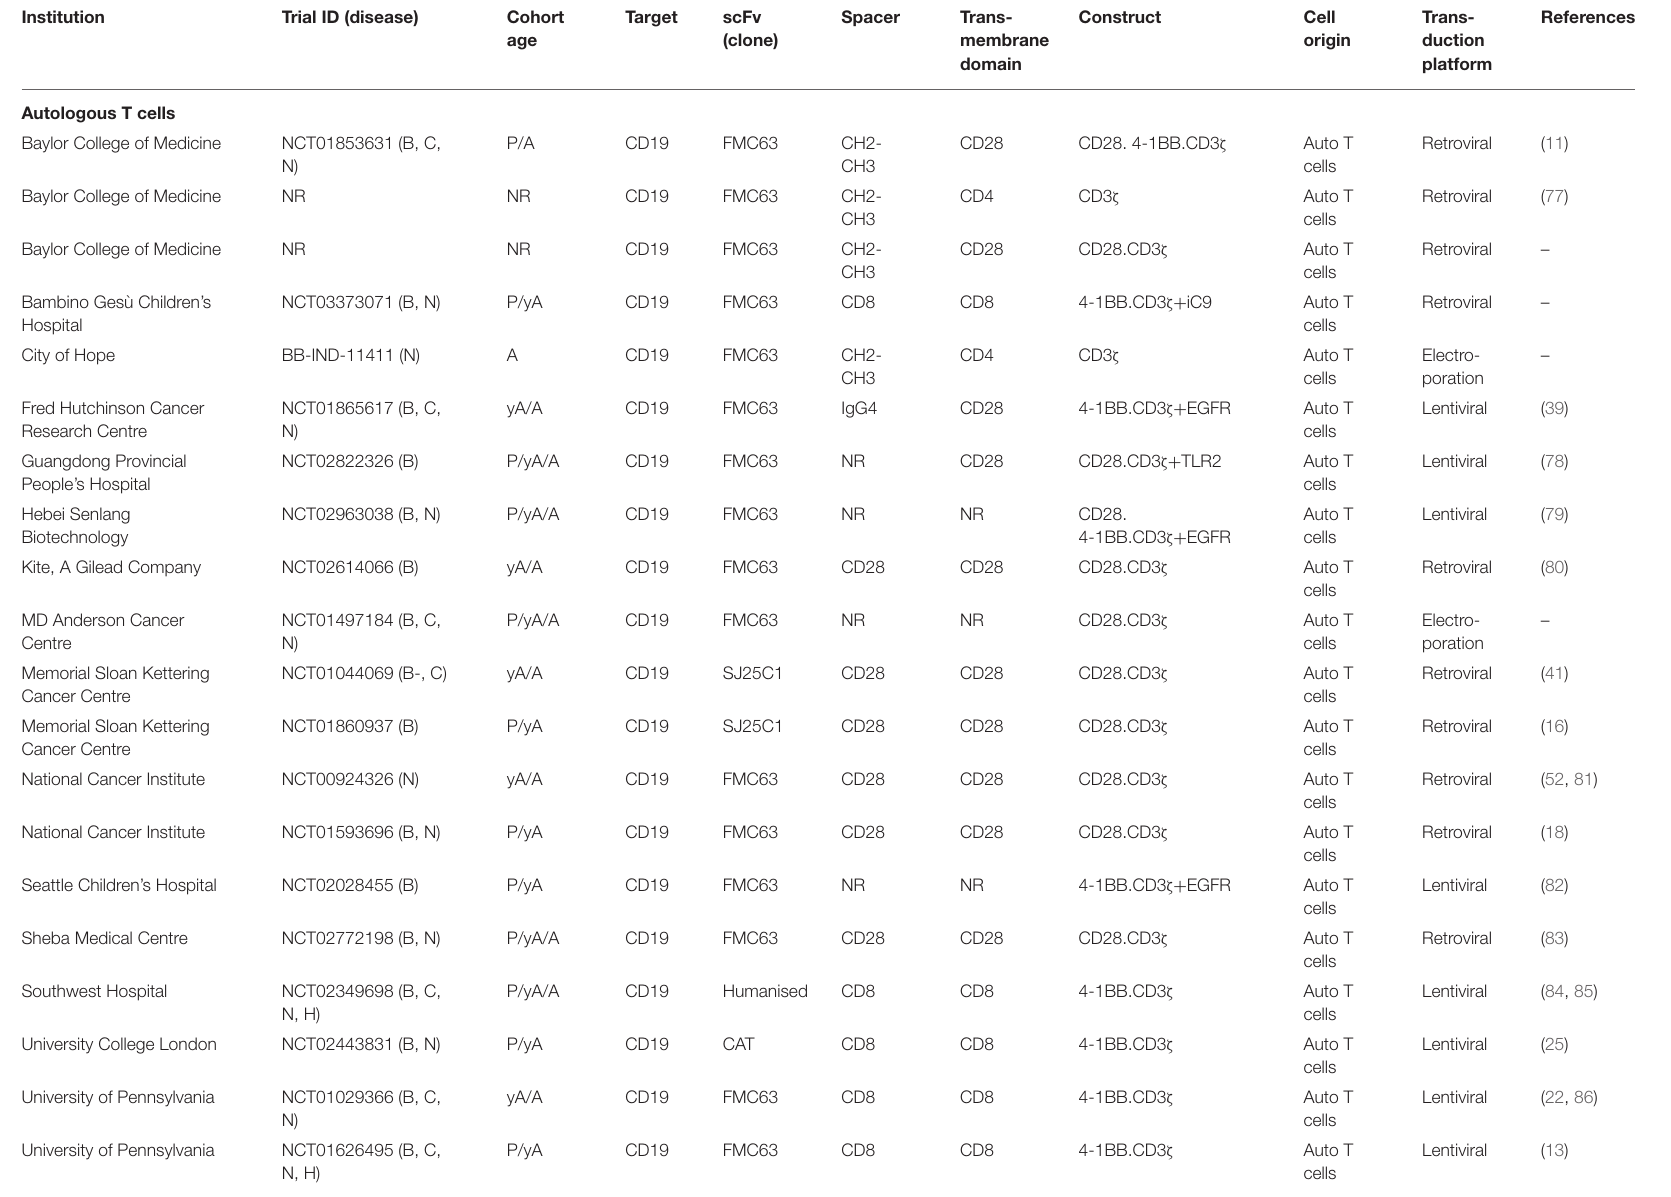
TABLE 3 | Overview of clinical trials for B-cell malignancies using CAR